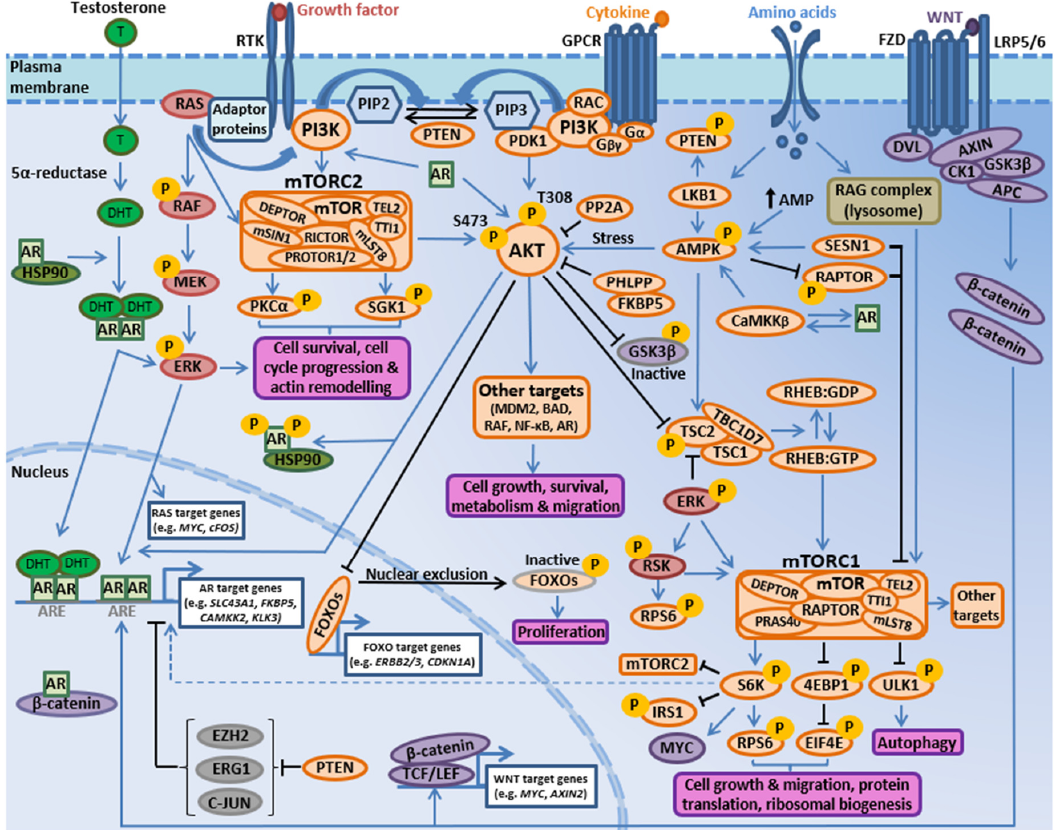
Figure 1. PI3K-AKT-mTOR signaling interaction with the AR, MAPK, and WNT pathways.